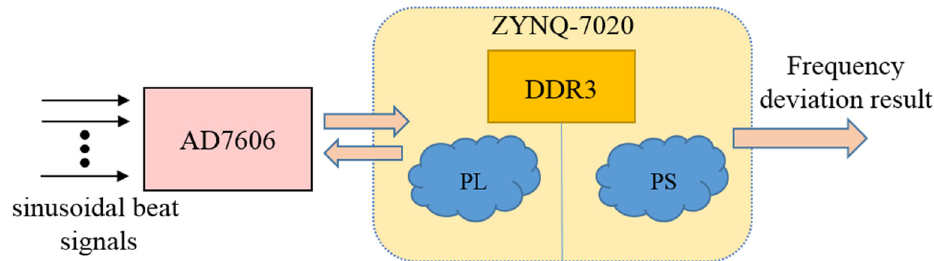
Figure 5. A block diagram of multi-channel data acquisition and analysis module.